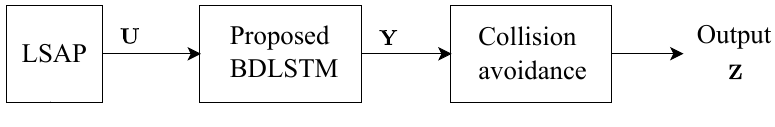
Figure 3. Proposed system model.